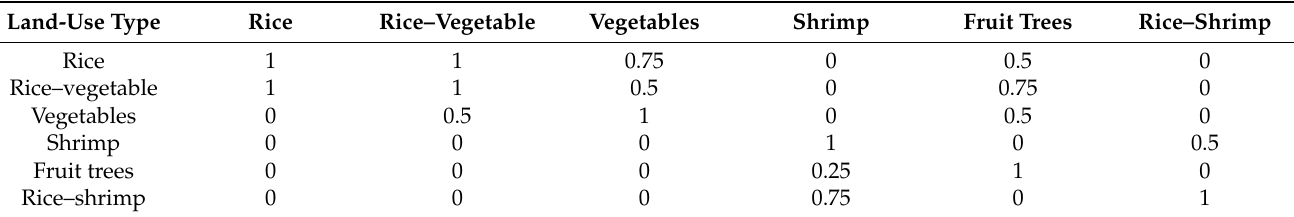
Table 1. Difficulty ratings for changing between different land-use